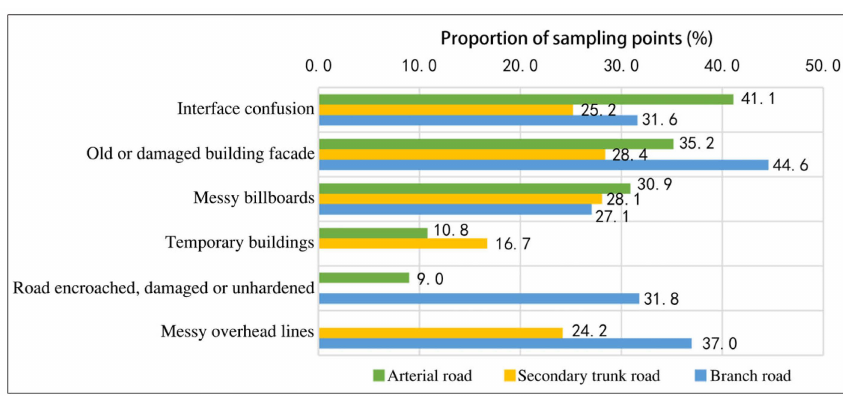
Figure 15. Statistics of prominent problems in various street